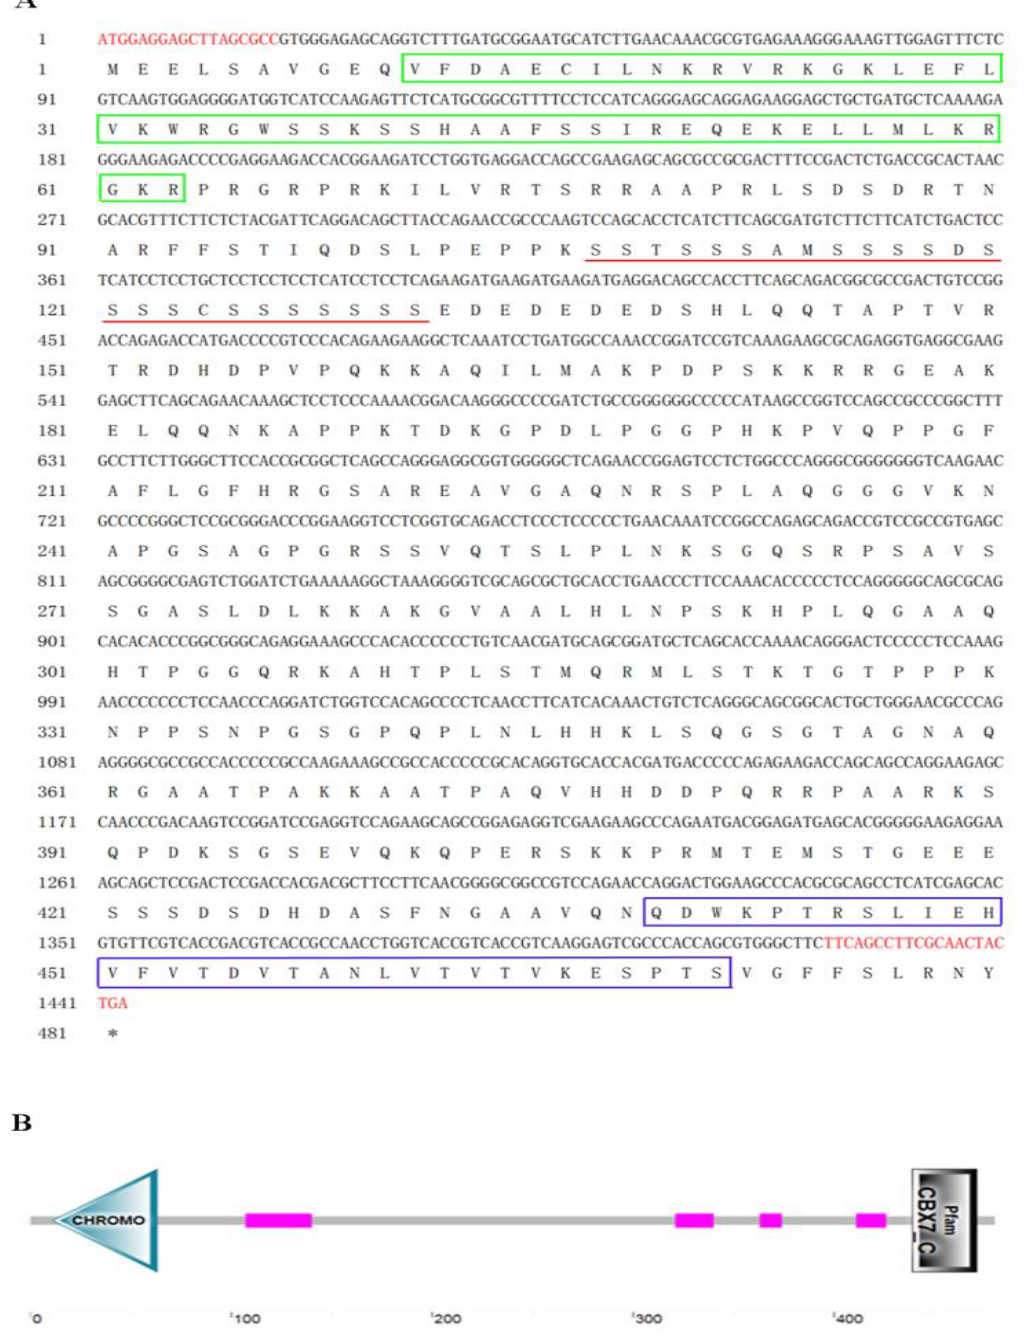
Figure 1. The cDNA sequences and the derived protein sequence of medaka cbx2 ( A ). The red font position represents the cloning primers, the Chromo domain is marked by a green box, the Pfam domain is marked by a blue box, and the underlined sequence indicates the serine-rich region. The secondary structure of CBX2 in medaka ( B ).